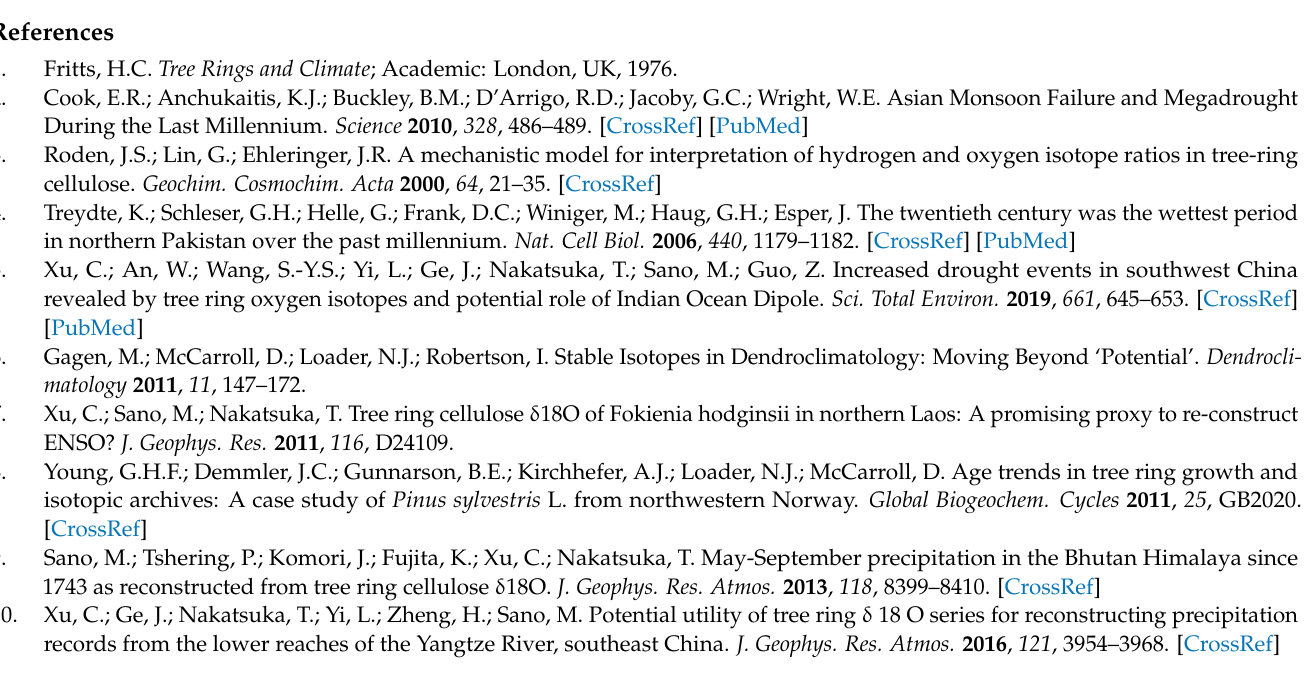
Table S1: The time span of ice cores presented in Figure